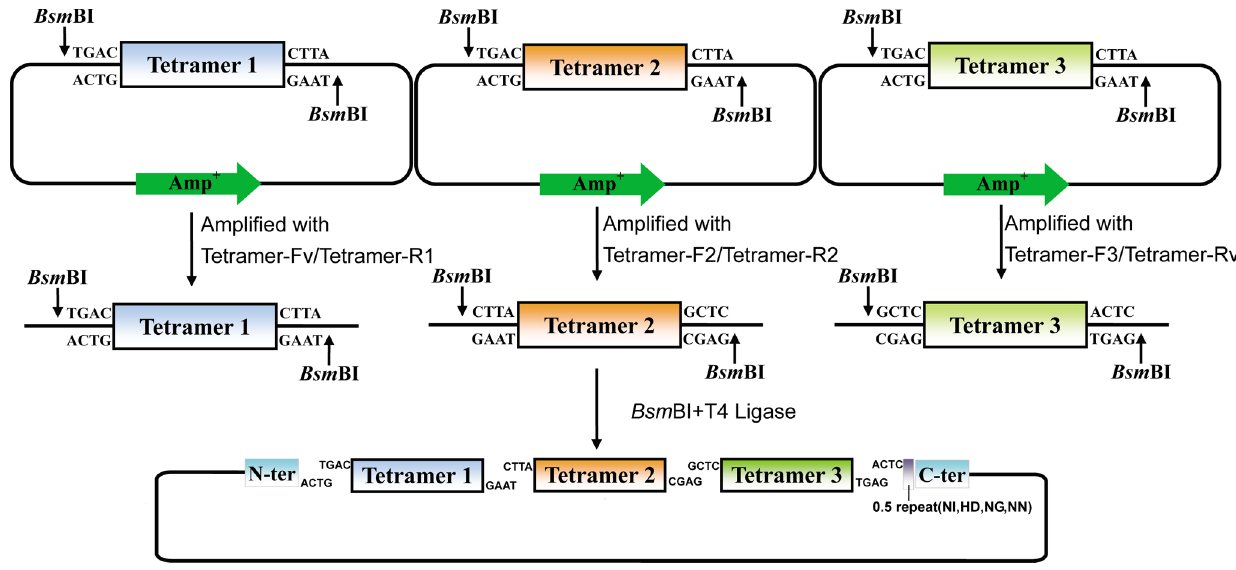
Figure 5. Construction of customized TALENs or TALE-TFs depending on the tetramer library. Three selected tetramer plasmids (Tetramer 1, Tetramer 2 and Tetramer 3) are amplified with separate primer pairs (Tetramer-F1/Tetramer-R1, Tetramer-F2/Tetramer-R2 and Tetramer- F3/Tetramer-R3) to be given unique cohesive ends specifying their positions in the assembly. The tetramers were then assembled and cloned into an expression backbone during a cut/ligation reaction.